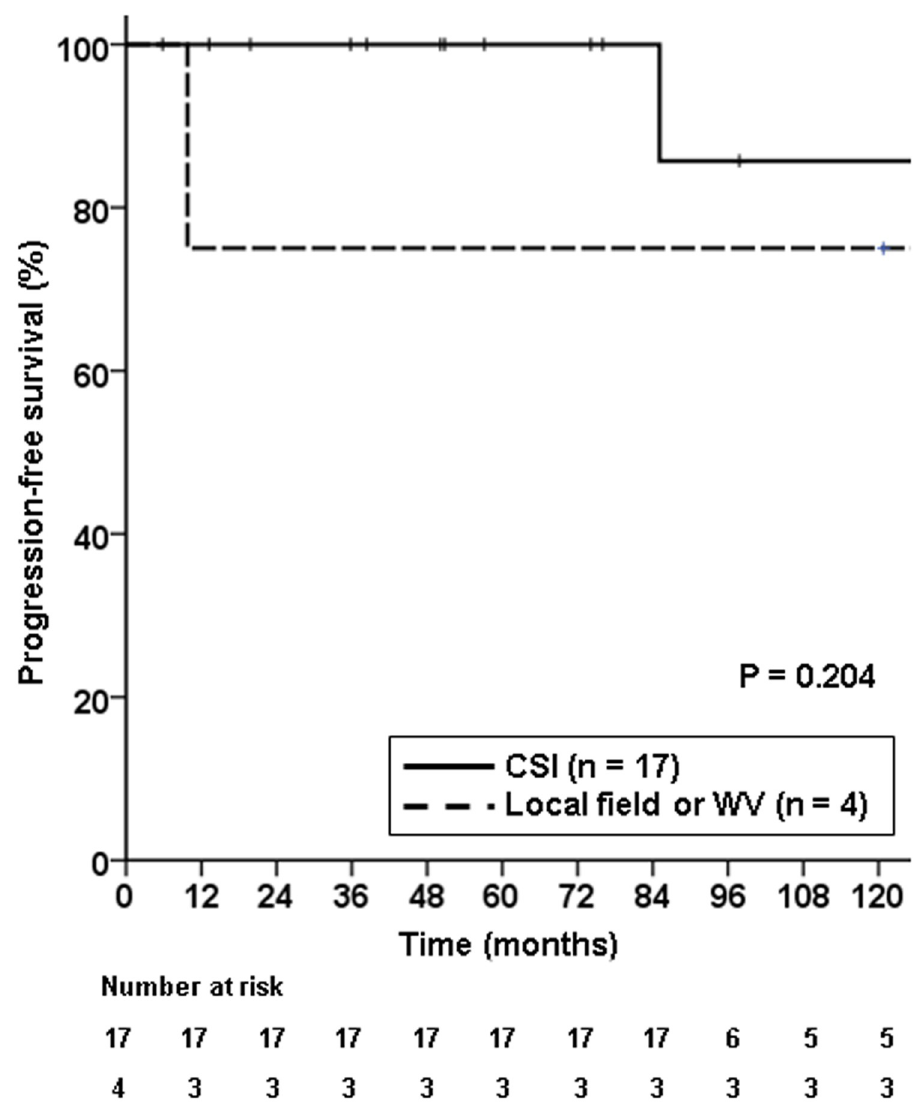
Fig 2. Progression-free survival according to the treatment field. Cranio-spinal irradiation tended to show better progression-free survival, although not statistically significant (p = 0.204)).